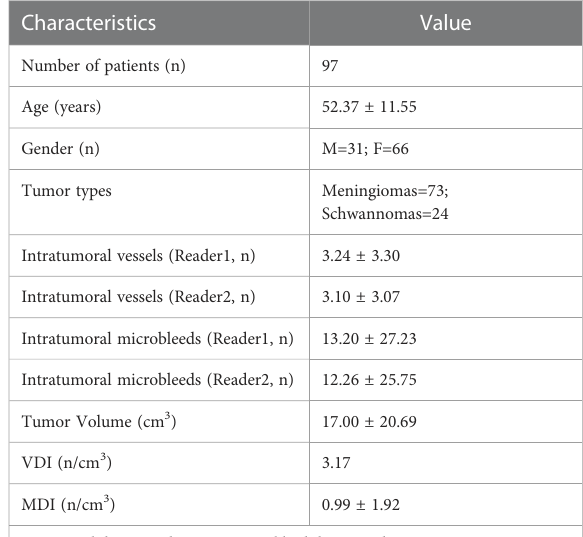
TABLE 1 Characteristics of patients included in the study.